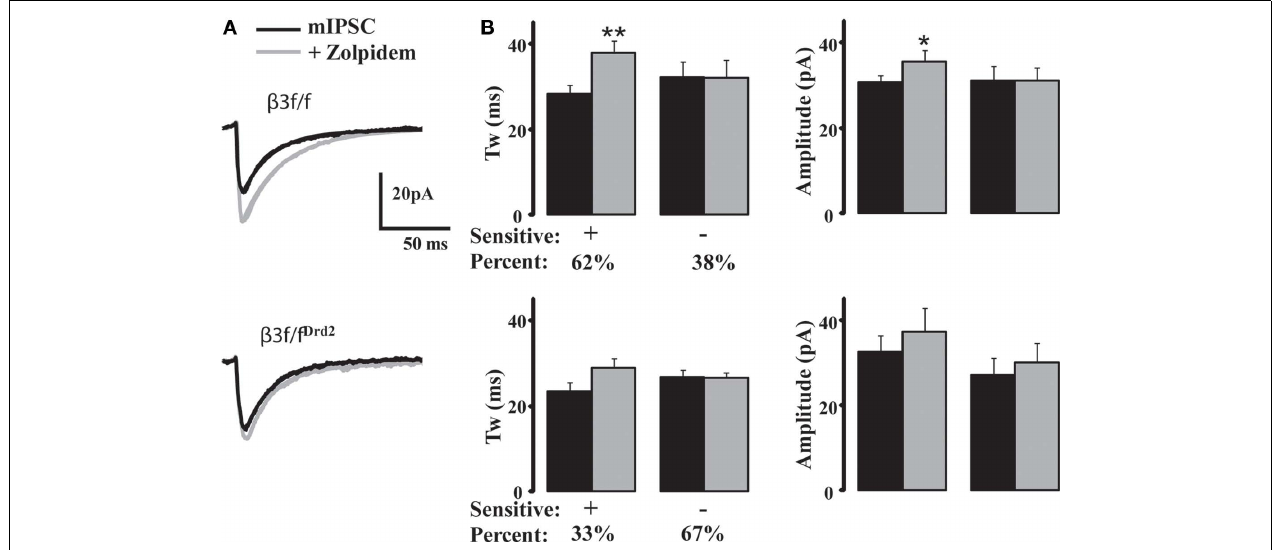
FIGURE 5 | Zolpidem fails to modulate majority of mIPSCs in MSNs from conditional KO mice. (A) Averaged representative mIPSC traces from a β 3f/f (top) and a β 3f/f Drd2 (bottom) neuron with zolpidem (1 μ M). (B) Summary graphs showing zolpidem sensitivity on β 3f/f (top) and β 3f/f Drd2 (bottom) MSN kinetics (left) and amplitude (right). Cells were determined to be responders if their mIPSC decay increased at least 110% of control.The majority of neurons from control β 3f/f mice showed a significant mIPSC prolongation ( n = 15/24), while the majority of neurons from β 3f/f Drd2 mice did not ( n = 6/9). Cells derive from at least two mice in each